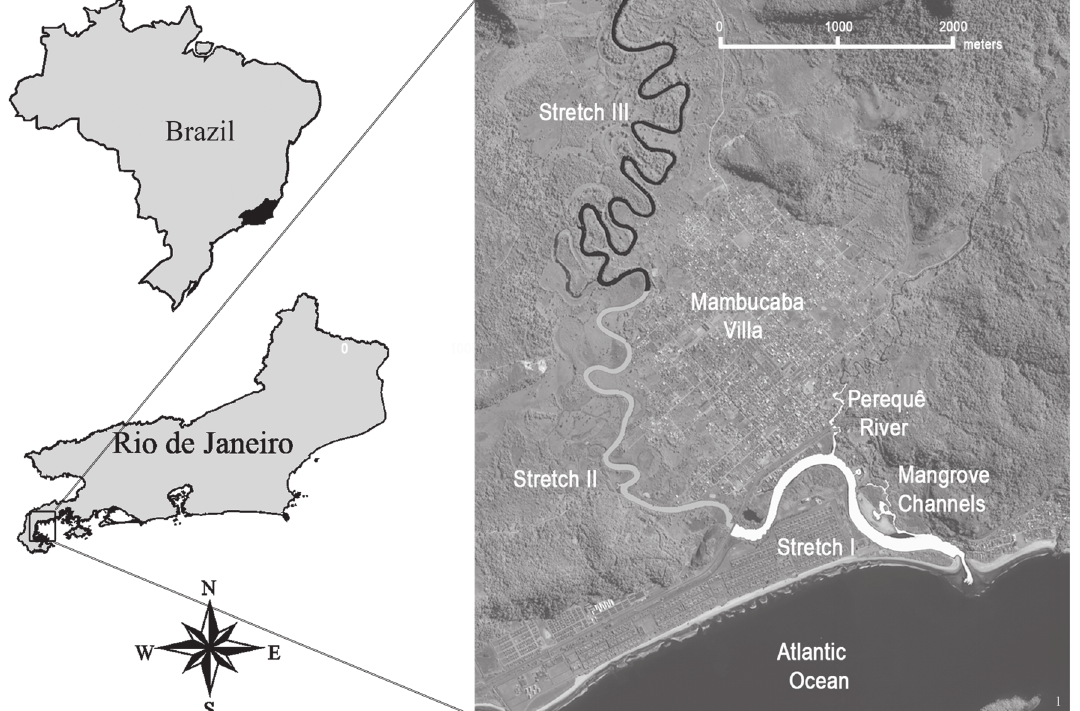
Figure 1. Location of the 13 kilometer study area along the lower Mambucaba River catchment (including mangrove channels and the Perequê River), Angra dos Reis municipality, on the southern Rio de Janeiro state coast, Brazil, showing the different stretches surveyed for Neotropical otter